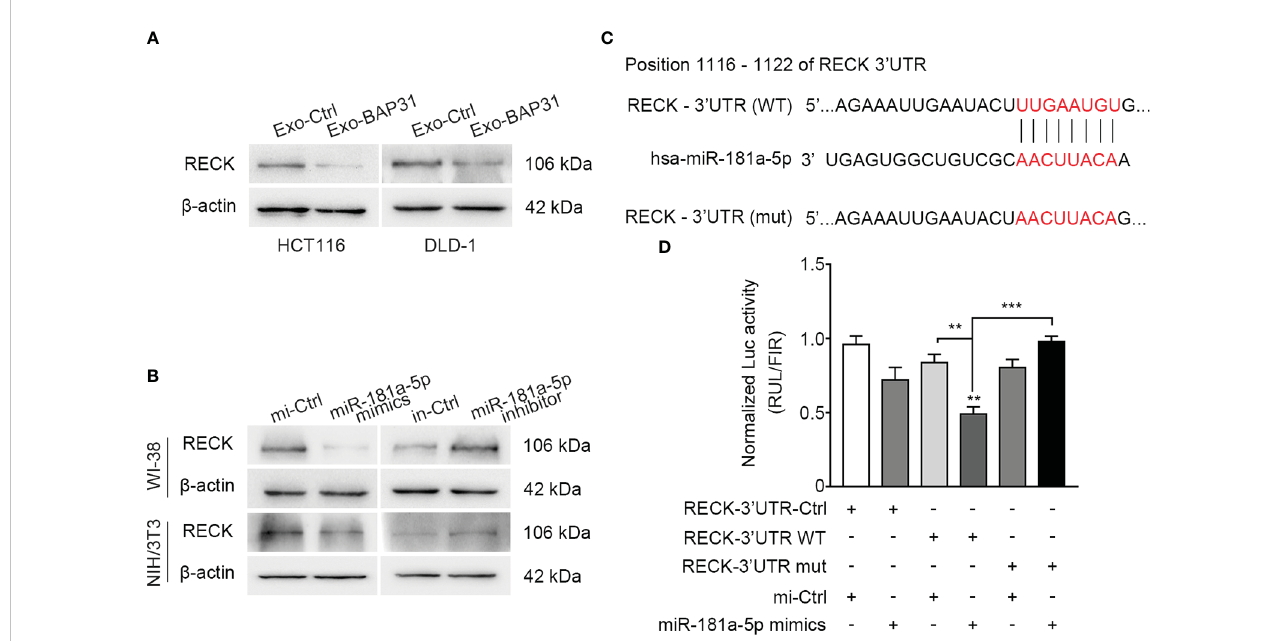
FIGURE 4 The 3 ′ UTR of RECK was a functional target of miR-181a-5p. (A) Fibroblasts were treated by exosomes from BAP31-overexpressing CRCs. Western blot analysis shows the RECK expression in the fi broblasts. (B) Fibroblasts were transfected with miR-181a-5p mimics to increase the miR-181a-5p expression of fi broblasts. Western blot analysis shows the RECK expression in the fi broblasts. (C) Schematic diagram shows the wild-type (WT) sequences of RECK 3 ′ -UTR binding sites matching for miR-181a-5p, and the mutant (mut) sequences of RECK 3 ′ -UTR. (D) Luciferase activities reporter shows the binding effect of miR-181a-5p to the RECK 3 ′ -UTR in HEK-293T. Mean ± SEM are provided (n = 3). ** p < 0.01 and *** p <